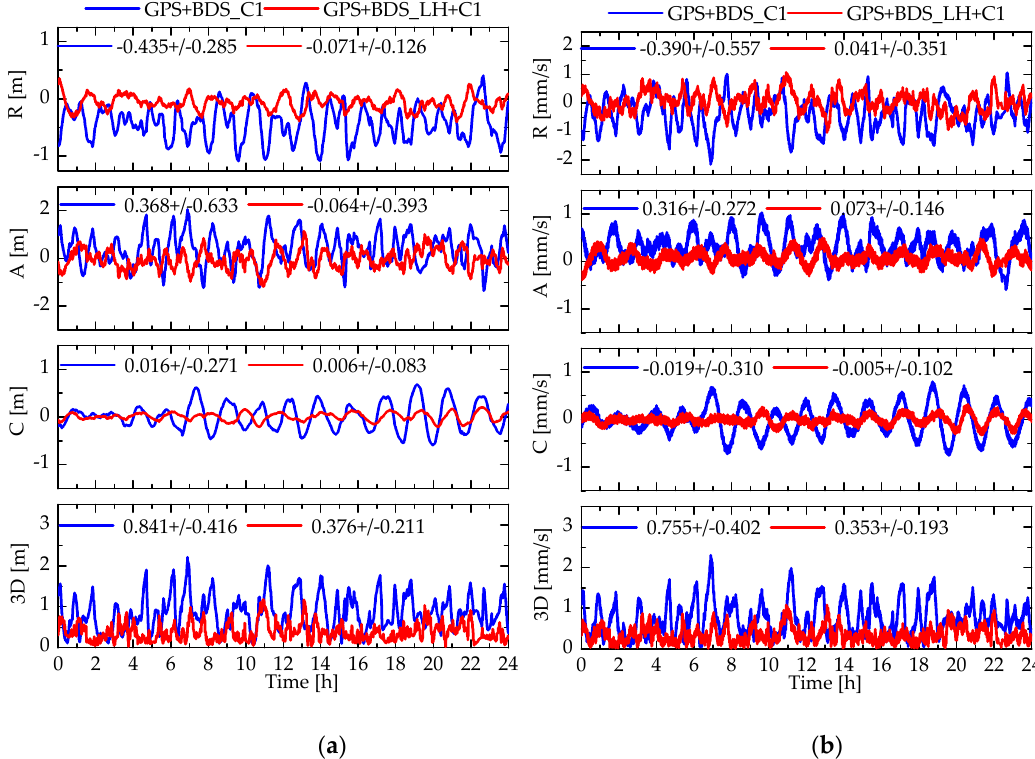
Figure 7. Comparison of real-time orbit errors of the pseudo-range-based and carrier-phase-based solutions for the FY3C satellite on day 2015/71: ( a ) The radial (R), along-track (A), cross (C), 1-dimensional (1D) and 3-dimensional (3D) position errors; ( b ) The R/A/C/3D velocity errors.